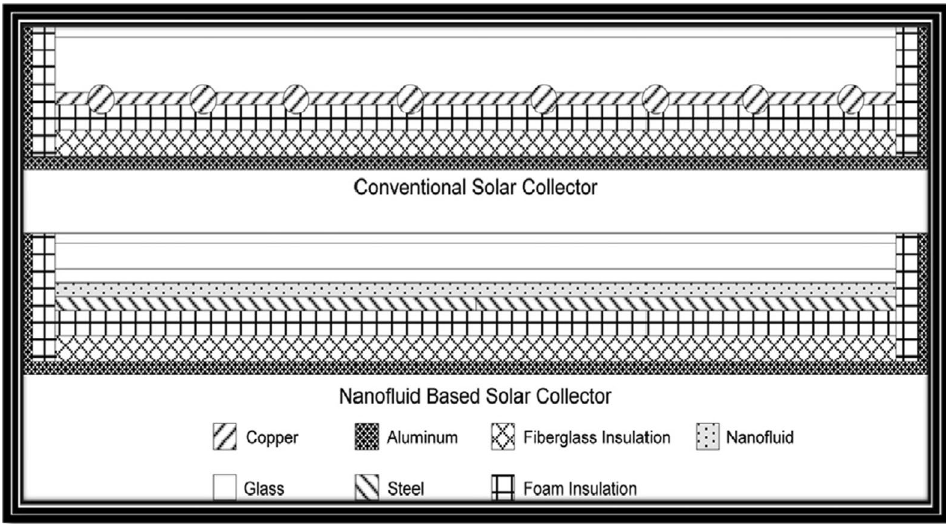
Fig. 9 Schematics and materials for both conventional and nanocollectors